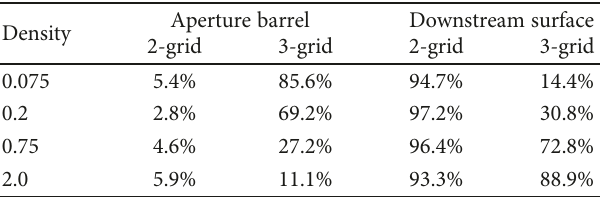
Table 11: Proportion of downstream re fl ux CEX ions impinging on the aperture barrel and the downstream